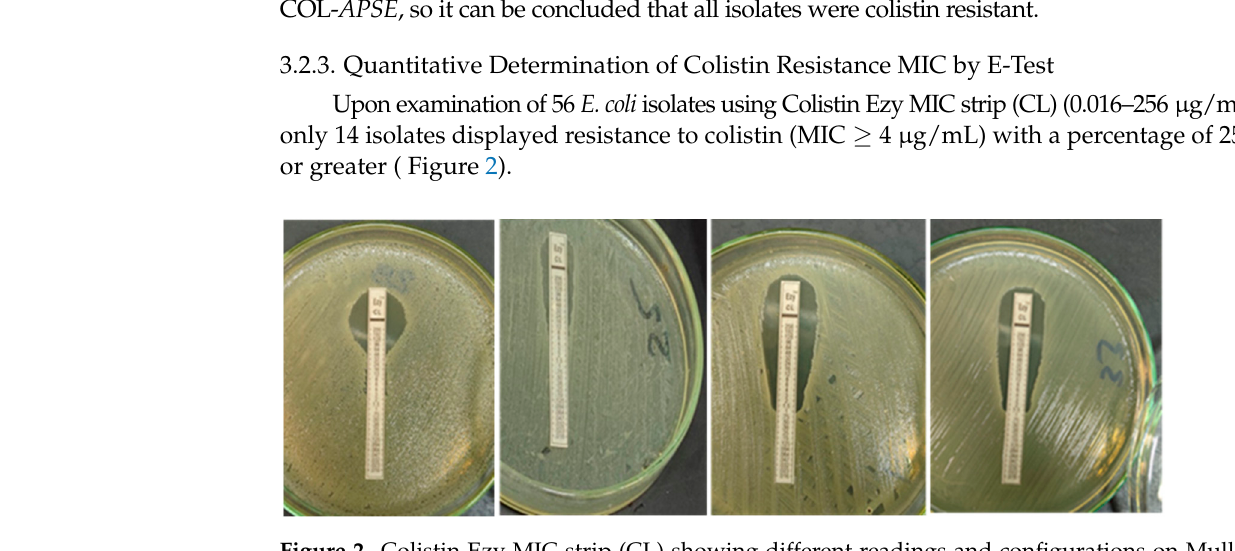
Table 3. Comparison of MIC values determined by Sensititre with those of E-Test. Code No.